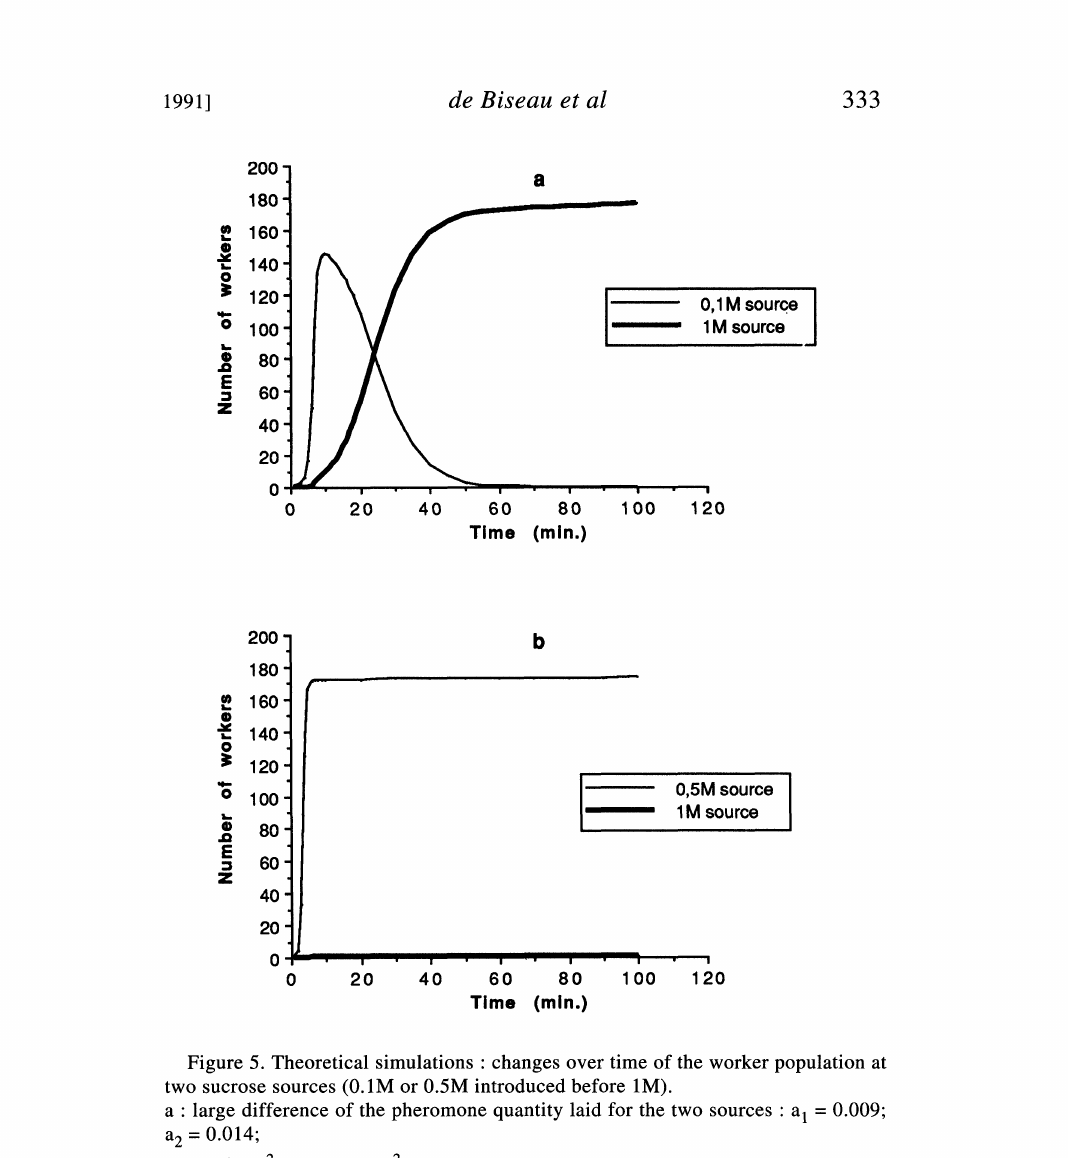
Figure 5. Theoretical simulations changes over time of the worker population at two sucrose sources (0.1M or 0.5M introduced before 1M). a large difference of the pheromone quantity laid for the two sources a